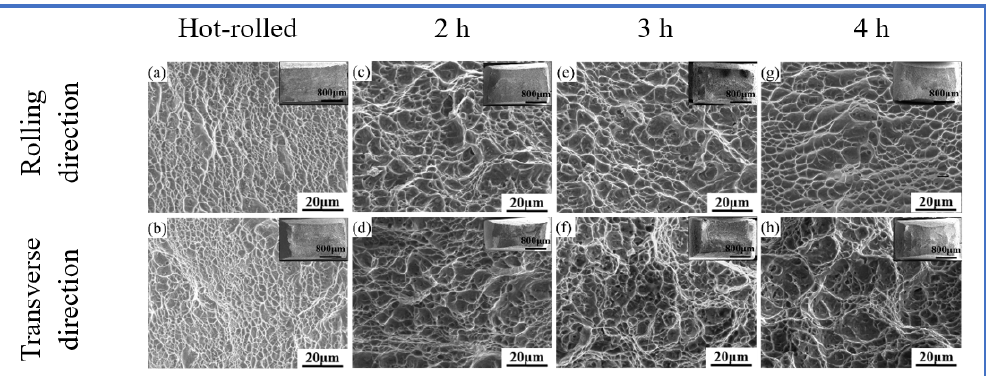
Figure 10. Fracture morphologies of TC4 alloy aged sheets.